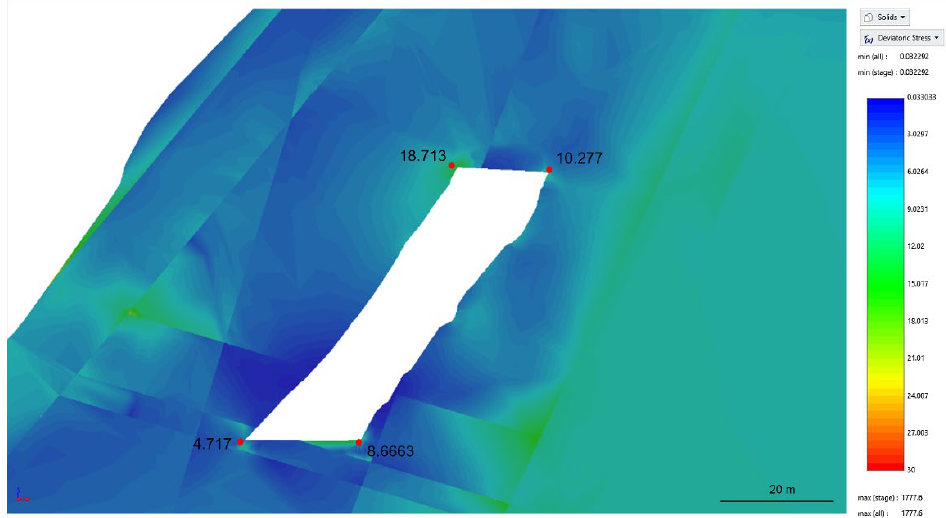
Figure 17. Deviatoric stress ( σ 1 – σ 3 ) of Section S1 calculated in MPa.